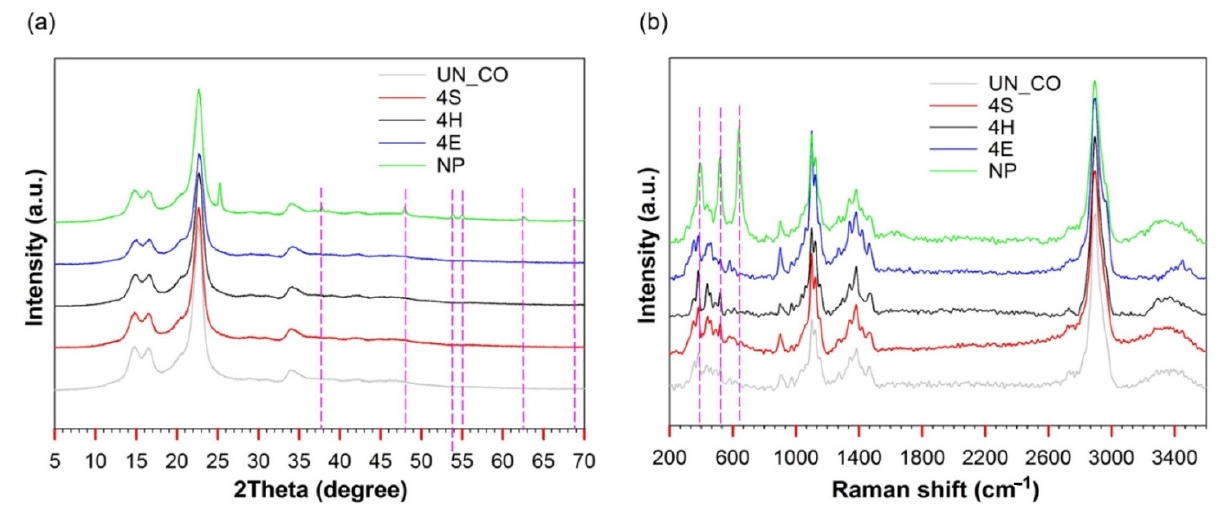
Figure 4. XRD ( a ) and Raman spectra ( b ) of untreated and TiO 2 treated cotton fabrics